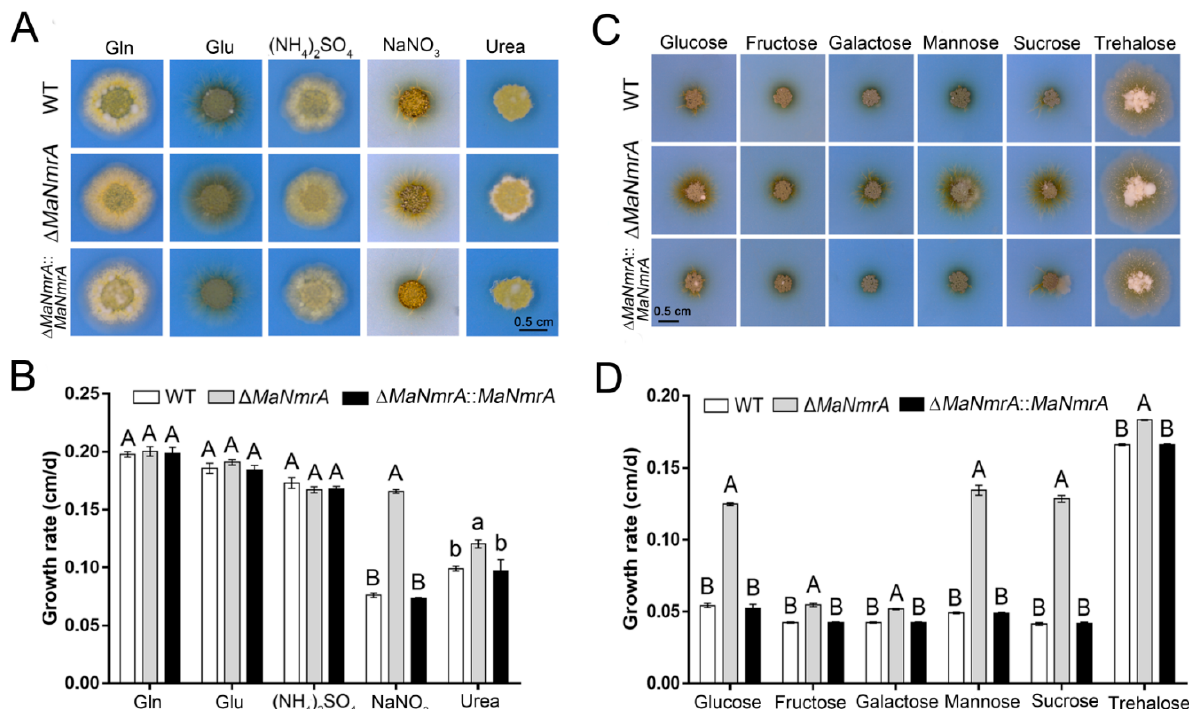
Figure 2. Deletion of MaNmrA affected the nitrogen and carbon utilization. Colony morphology ( A ) and growth rate ( B ) of the WT, Δ MaNmrA and ∆ MaNmrA :: MaNmrA strains on modified CZA medium supplemented with 25 mM Gln, Glu, (NH 4 ) 2 SO 4 , NaNO 3 , and urea, respectively. Colony morphology ( C ) and growth rate ( D ) of the WT, Δ MaNmrA , and ∆ MaNmrA :: MaNmrA strains on modified CZA medium supplemented with 88 mM glucose, fructose, galactose, mannose, sucrose, and trehalose, respectively. Letters A, B, a and b above graph were used to shown the significant difference. a and b, p < 0.05. A and B, p < 0.01 (Tukey’s HSD).